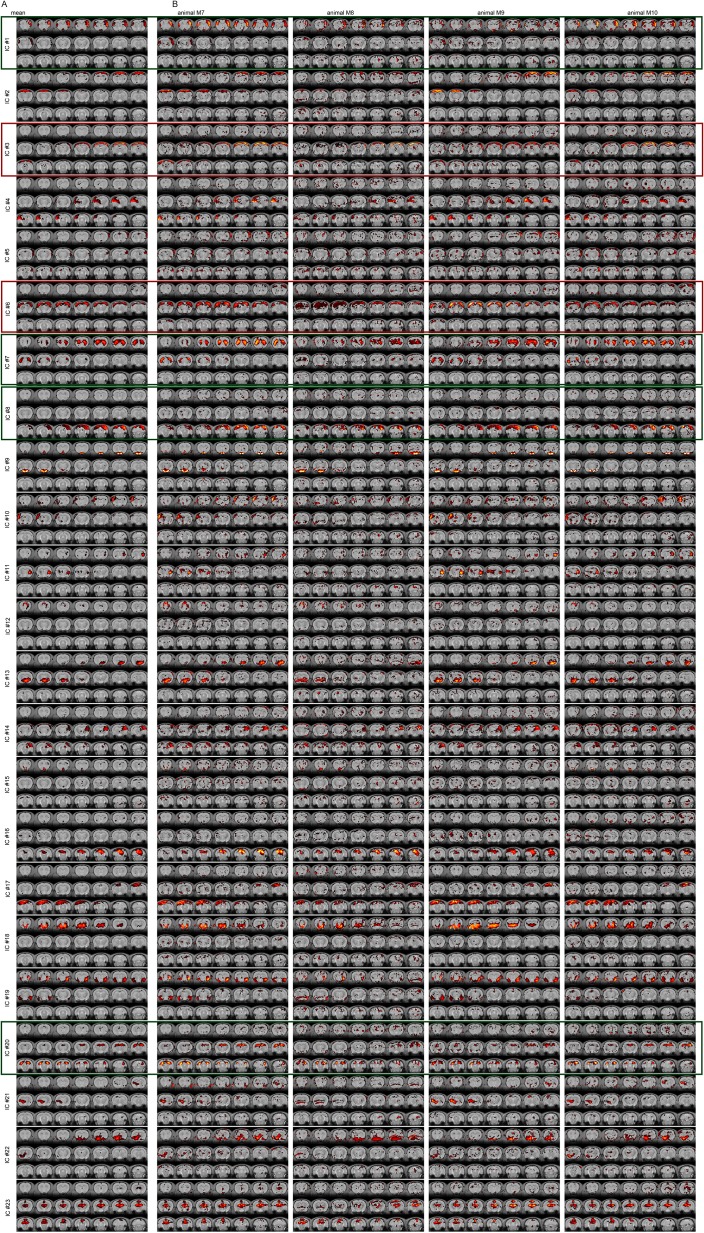
Complete component set of IC analysis in slow wave activity.(A) ICs derived from group ICA (B) corresponding single subject ICs sorted by their mean power in the range up to 0.1 Hz (higher to lower). ICs extracted based on minimum description length criterion (MDL) originally revealed 37 components, after visual inspection all components showing only activity outside the brain were discarded, resulting in a total of 23 components shown on 21 slices with a distance of 0.6 mm between the slices and an isovoxel resolution of 0.3 mm³ after DARTEL normalization and reconstruction. Components #3 and #6 show pancortical activation (outlined in red), components related to typical default mode activity networks including auditory (IC #1) and visual (IC #8) cortex, striatum (IC #7) and hippocampus. (IC #20) were also identified (outlined in green).